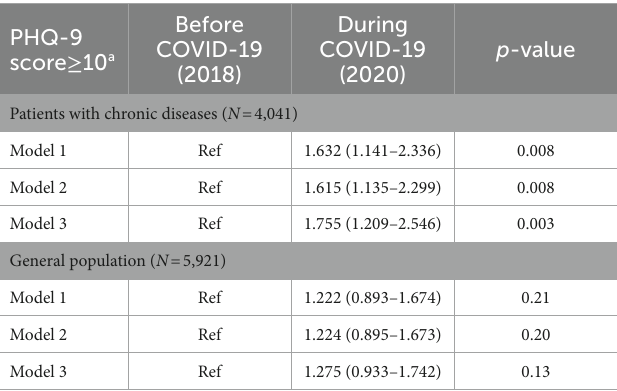
TABLE 4 Change in the prevalence of depressive symptoms between the pre-pandemic and during pandemic periods in patients with chronic diseases and the general